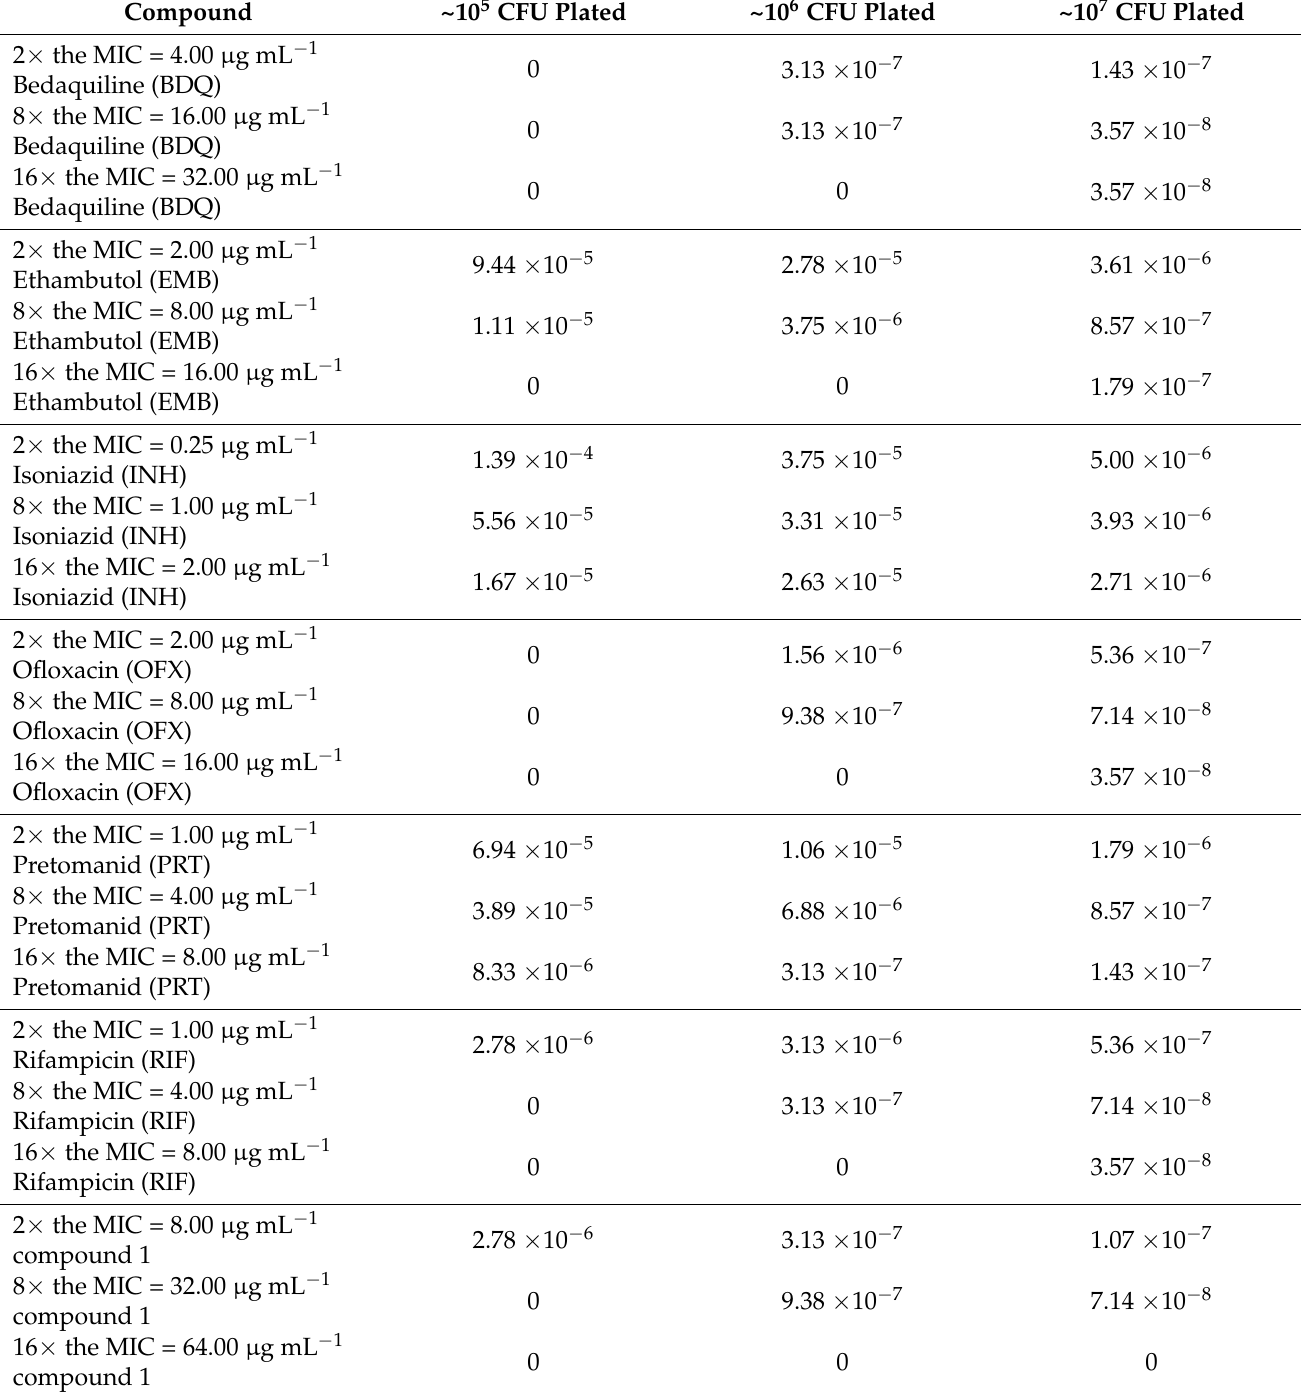
Table 8. Frequencies of resistance of M. tuberculosis strain H37Rv against standard control and test sample drug compounds at 2 × , 8 × , & 16 × the MIC on 7H10 agar; i.e., µ M for compounds 1 , 18 and 22